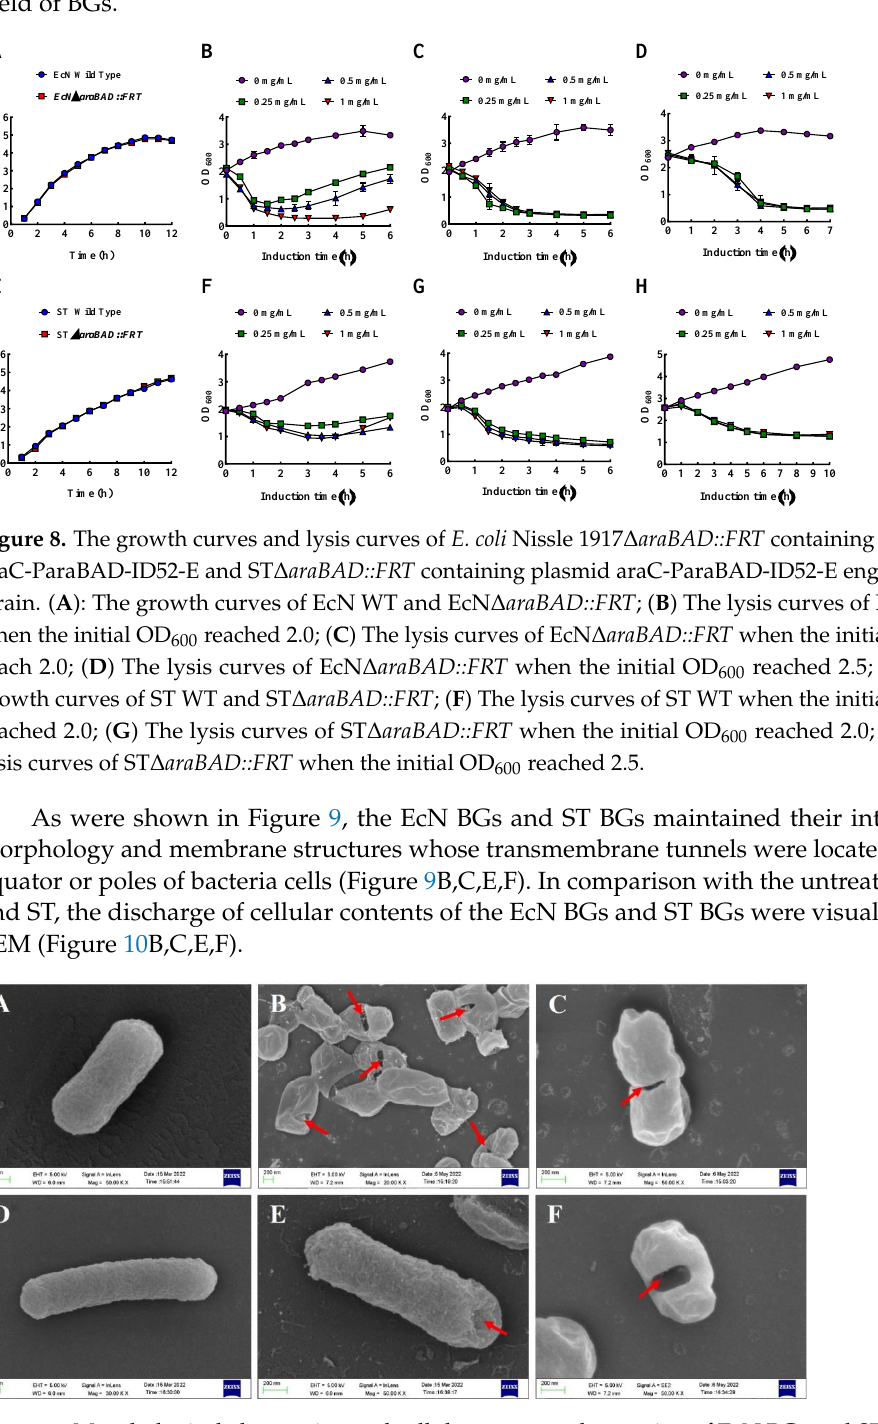
Figure 9. Morphological observation and cellular contents observation of EcN BGs and ST BGs by SEM. ( A ): Untreated control EcN cells; ( B , C ): EcN ghosts; ( D ) untreated control ST cells; ( E , F ): ST ghosts. The red arrows indicated the lysis transmembrane tunnels.